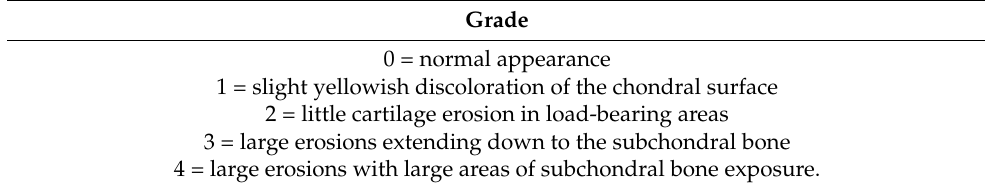
Table 1. Likert scale (Guingamp macroscopic